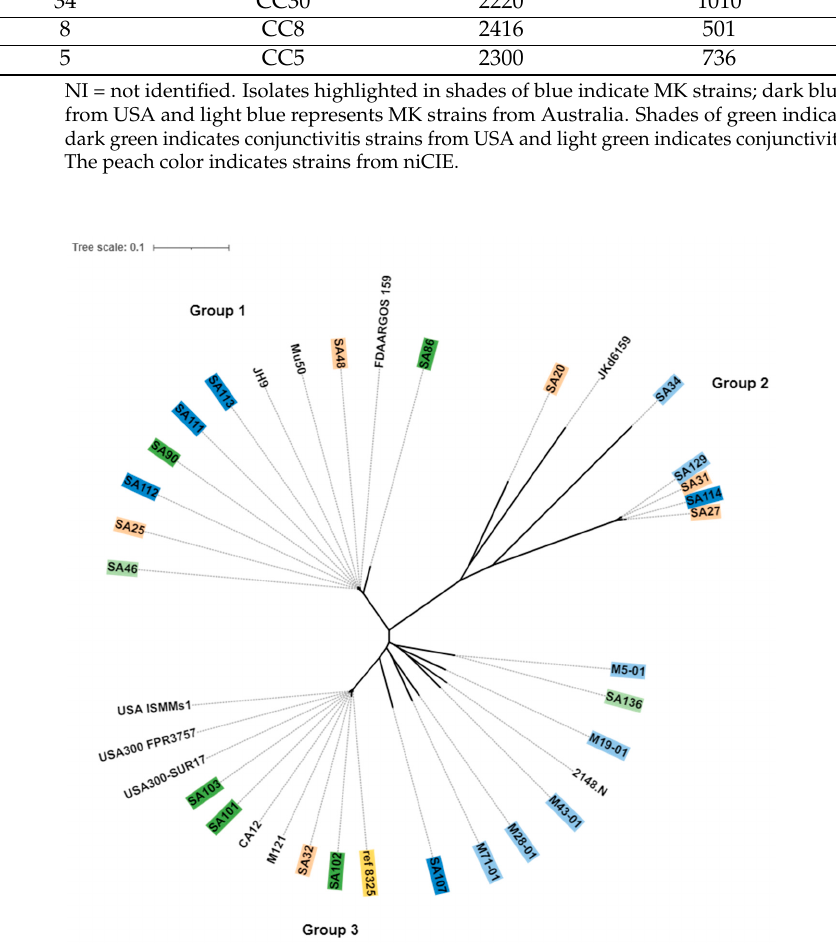
Group 3 was further divided into two subgroups; isolates with the same pangenome and CC or ST were clustered together. Isolates in group 3 had a large number of pan genes. Isolates belonging to the same sequence type or clonal complex were grouped together, for example, isolates 129, 31, 114, 27 were from clonal complex 30.